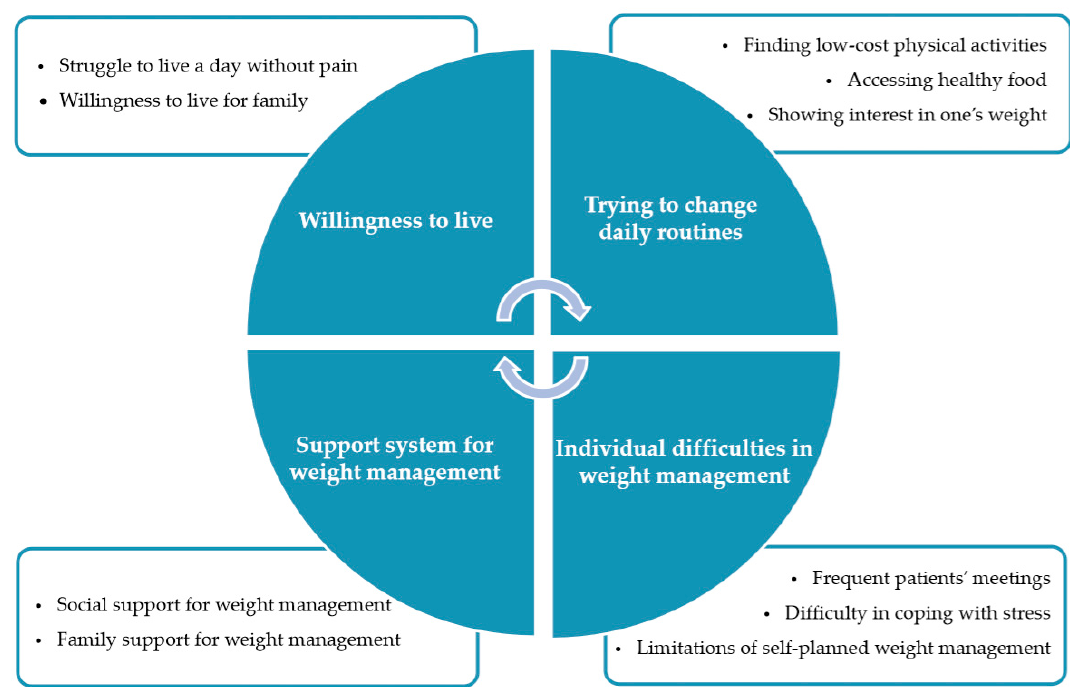
Figure 1. Theme of weight management experiences of breast cancer patients treated with tamoxifen.